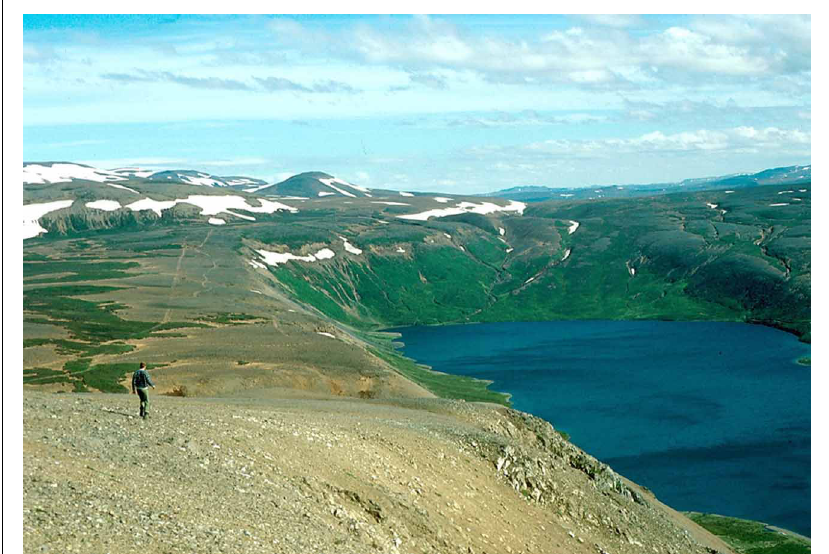
FIGURE 6 | Energy sources driving earthquakes. Major fault zones receive much energy (primarily elastic energy) through plate movements. View east, part of the Husavik-Flatey transform fault in North Iceland ( Figure 3 , Gudmundsson, 1995, 2000) showing a sag pond (Lake Botnsvatn) formed along normal faults. We still do not know of much of the energy stored in fault zones is available to drive large-scale seismogenic